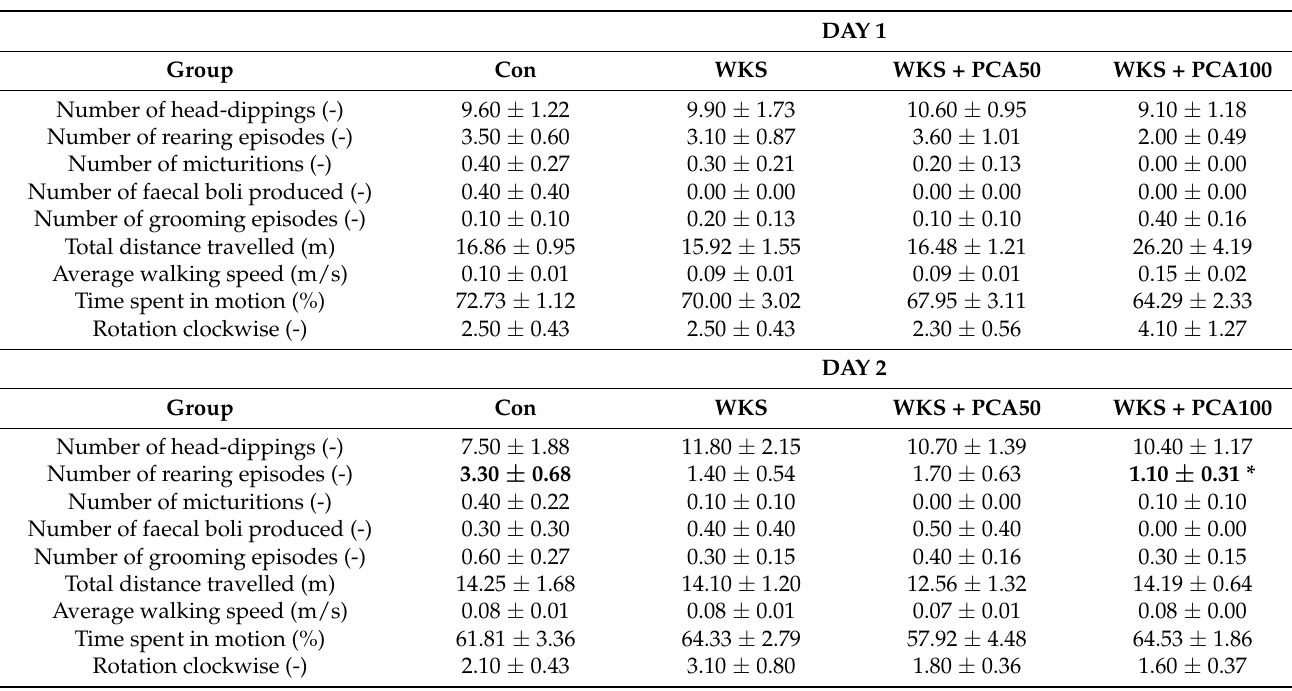
Table 2. Effect of long-term oral administration of PCA at doses of 50 mg/kg or 100 mg/kg on the behaviour of rats in the Hole–Board test in PTD-model of